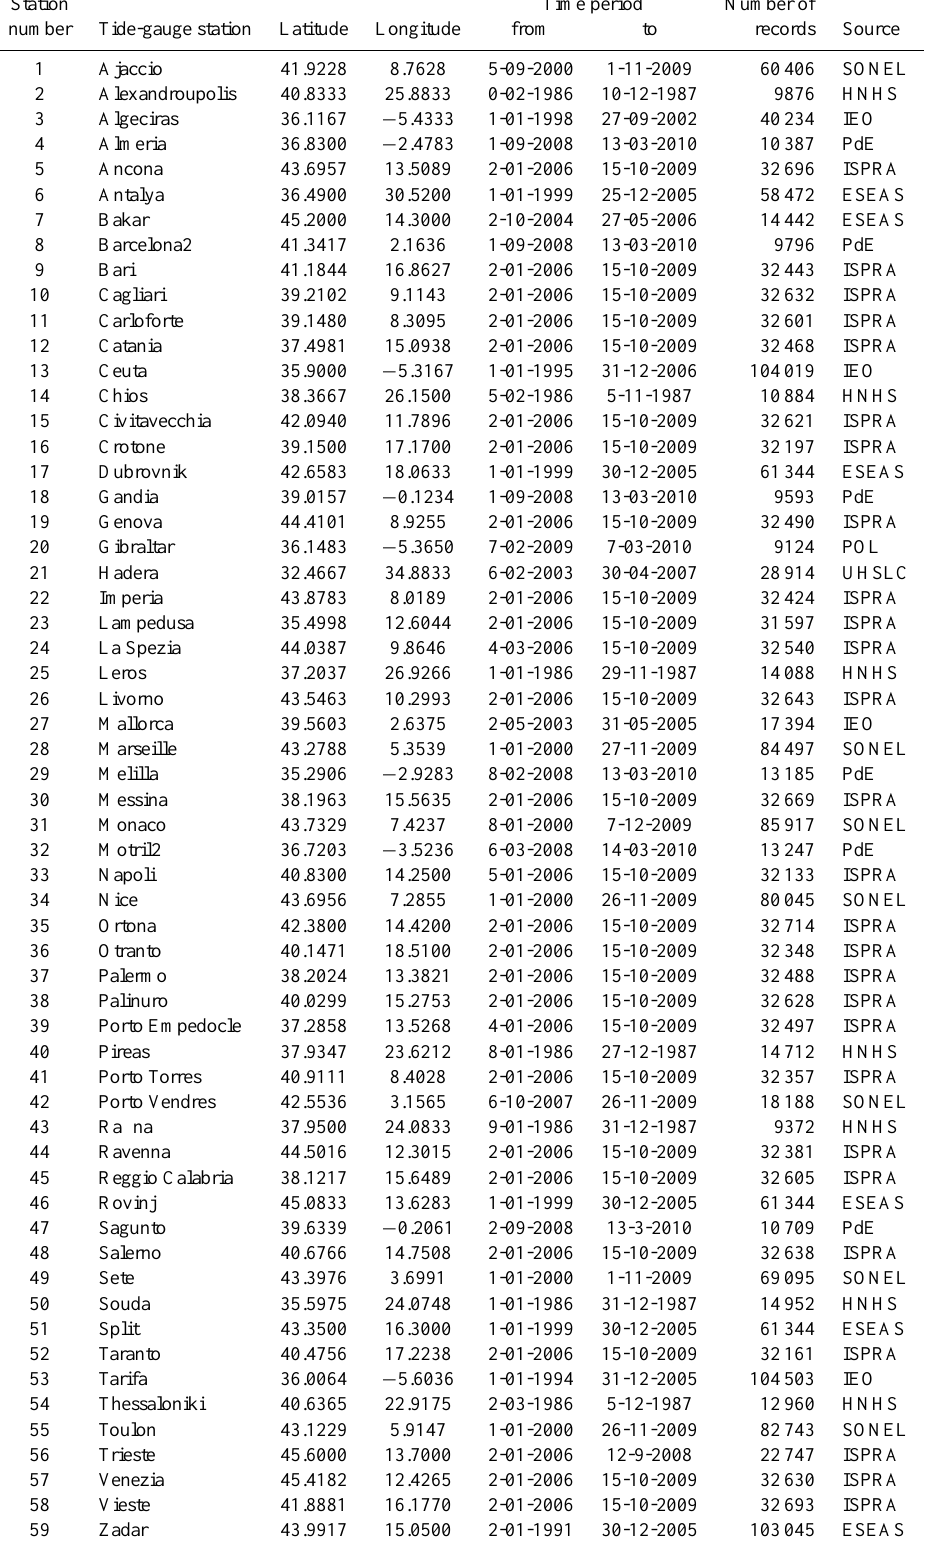
Table 1. Time period, number of records and sources of tide-gauge